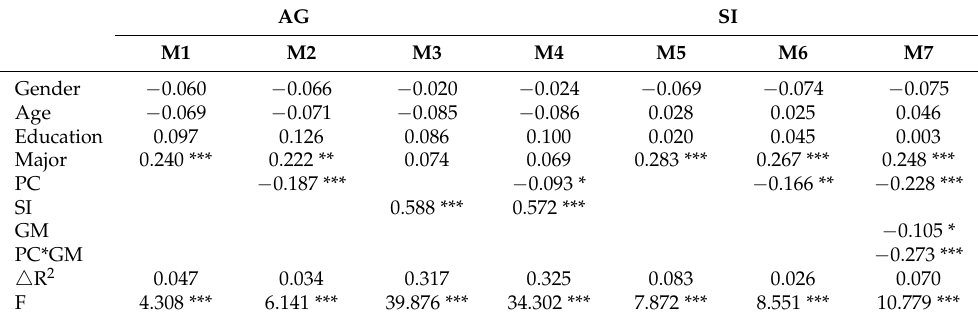
Table 4. Hierarchical regression ( N =